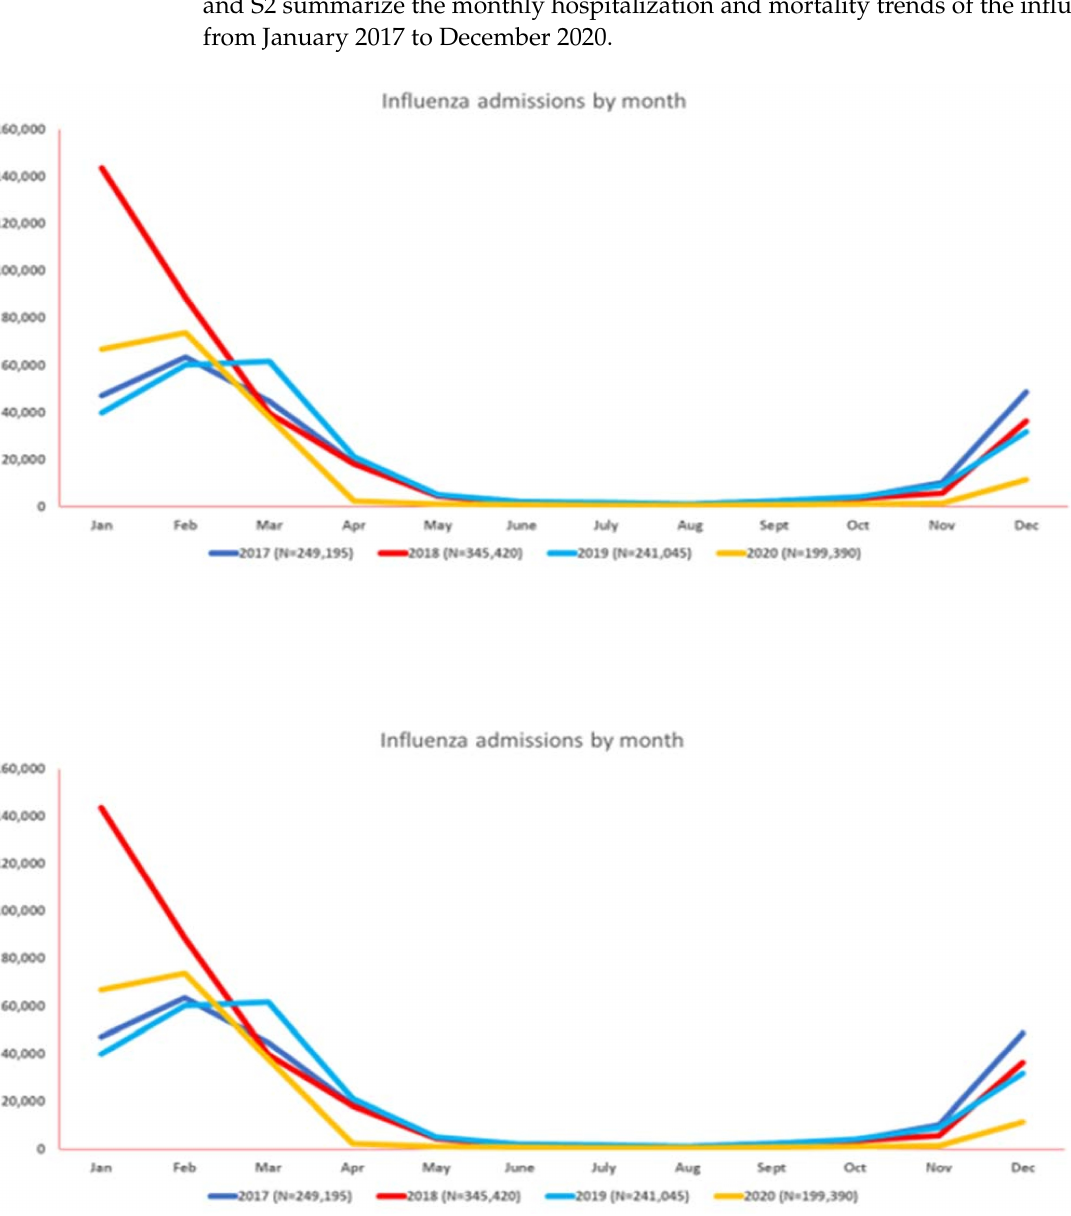
Figure 1. Monthly seasonal variation in the amount of influenza virus activity (hospitalizations at top, mortality at bottom) from